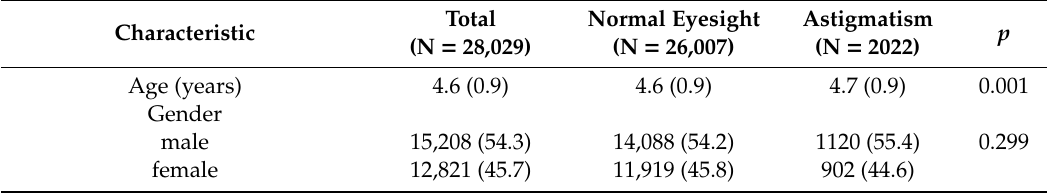
Table 2. Characteristics and comparison of preschoolers with astigmatism and those with normal